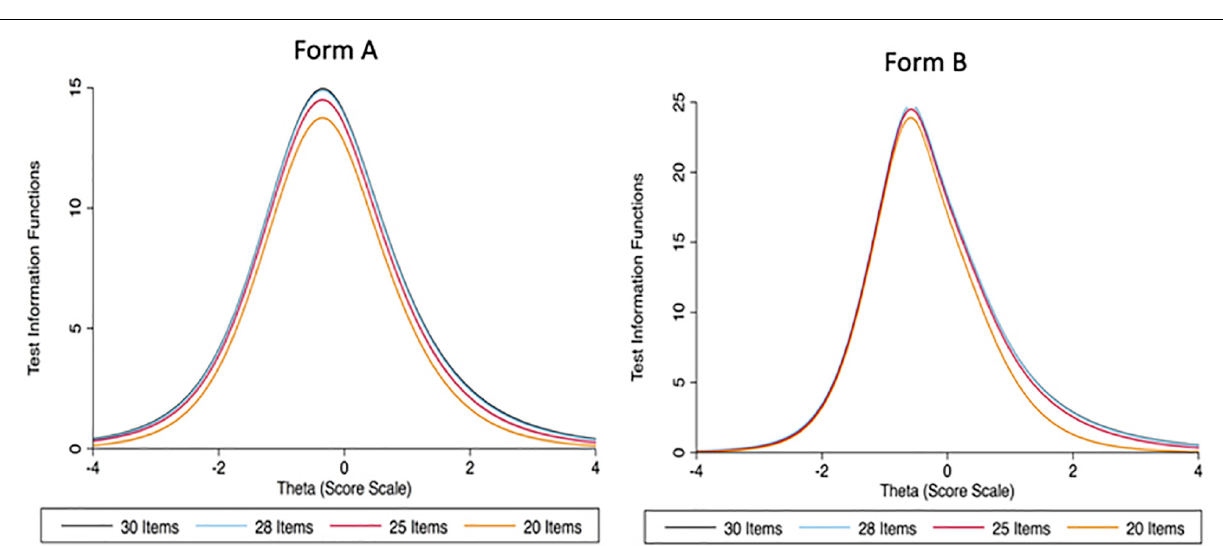
FIGURE 3 | Examples of removed items due to low discrimination indices. The target for the left panel was to turn (option 4), the target for the right panel was to talk (option 3).